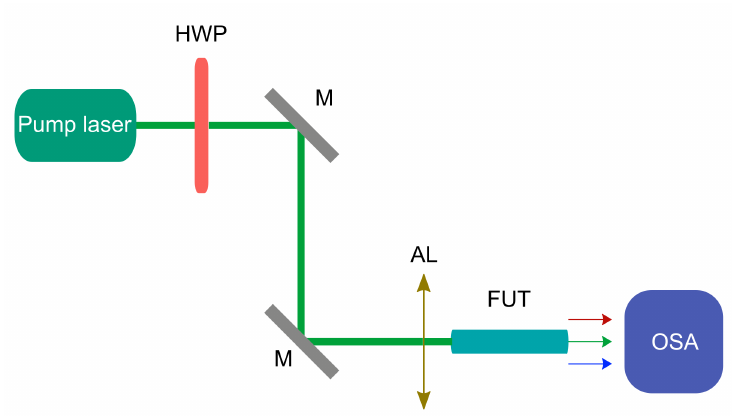
Figure 8. Experimental arrangement. Half-wave plate (HWP). Mirror (M). Aspherical lens (AL). Fiber under test (FUT). Optical spectrum analyzer